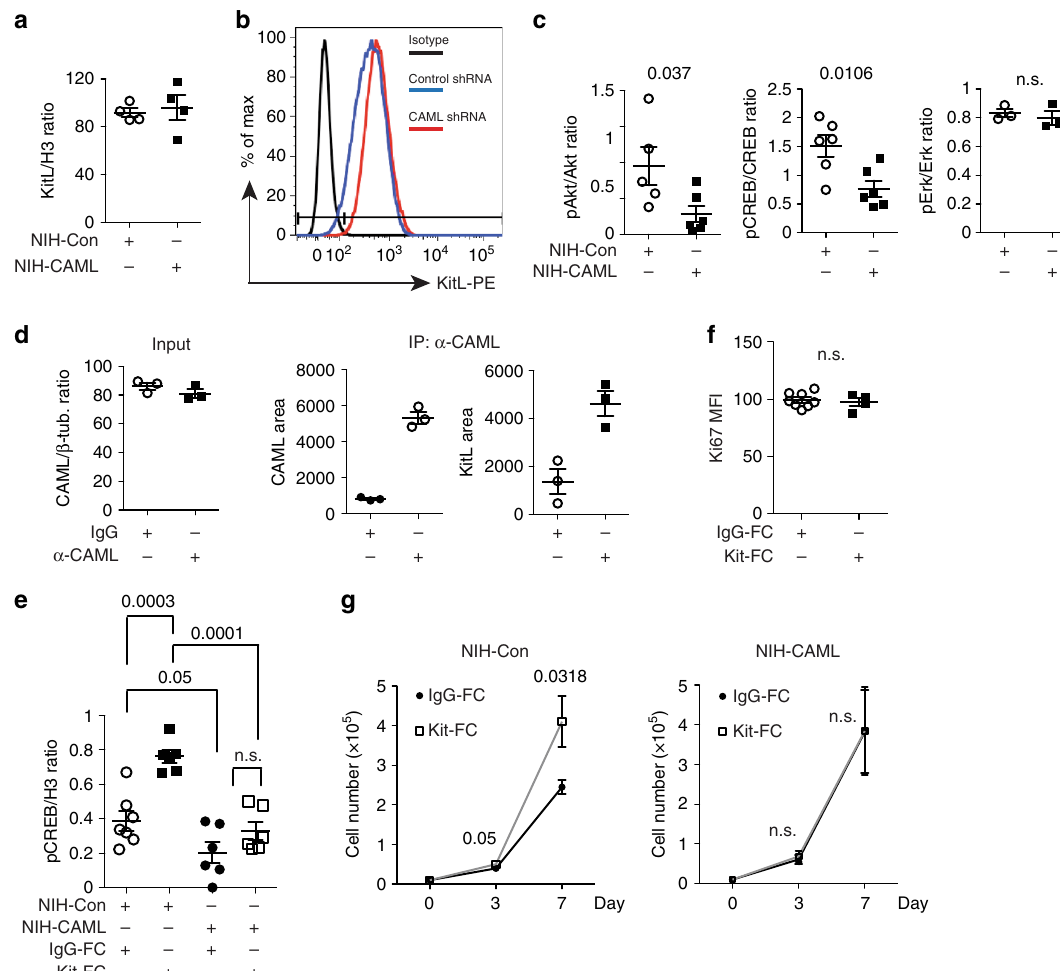
Fig. 4 CAML is required for mKitL signal transduction and proliferation induction. a Expression of mKitL in NIH3T3 cells transduced with lentivirus expressing CAML shRNA (NIH-CAML) and Control shRNA (NIH-Con), as indicated. Protein levels were quanti fi ed by western blotting, and mKitL normalized to Histone H3 ( N = 4, three experiments). Bars show mean ± s.e.m. P -value is shown (Student ’ s t -test). b Flow cytometry analysis of surface mKitL expression in cells from a , using an anti-KitL antibody or corresponding isotype control (Isotype). Data are representative of two experiments. c Quanti fi cation of phospho-Akt, -CREB and – Erk in NIH-CAML and NIH-Con cells gown in medium with 2% FBS. Protein levels were quanti fi ed by western blotting, and phospho-protein levels normalized to the corresponding total protein ( N = 6, three experiments). Bars show mean ± s.e.m. P -value is shown (Student ’ s t -test); n.s. not signi fi cant. d Quanti fi cation of CAML input protein (left), and CAML (centre) and KitL protein immuno-precipitated by control IgG (IgG) and anti-CAML antibody ( α -CAML) as indicated. Proteins were quanti fi ed by western blotting ( N = 3). CAML input was normalized to β -tubulin. Bars show mean ± s.e.m. P -value is shown (Student ’ s t -test). e Quanti fi cation of CREB phopho-Ser133 in NIH-CAML and NIH-Con cells, incubated in 0.5% FBS medium for 24 h and stimulated with 200 ng/ml IgG-Fc or Kit-Fc for 8 h, as indicated ( N = 6 in two experiments, except IgG-Fc-treated NIH-Con ( N = 7, two experiments)). P -values are shown (Student ’ s t -test). f MFI of Ki67 expression in NIH-CAML cells grown in 2% FBS medium and stimulated with 200 ng/ml IgG-Fc or Kit-Fc for 8 h, measured by intracellular fl ow cytometry ( N = 5, two experiments). Bars show mean ± s.e.m. P -value is shown (Student ’ s t -test); n.s. not signi fi cant. g Proliferation curve of NIH-Con (left) and NIH-CAML cells (right) grown in 2% FBS medium with 200 ng/ml IgG-Fc or Kit-Fc. Medium was changed every 48 h. Cells were counted at 0, 3, and 7 days ( N = 6 for each time point, two experiments). Bars show mean ± s.e.m. P -values are shown (Student ’ s t -test); n.s. not signi fi